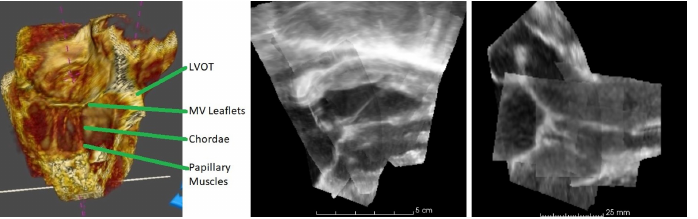
Figure 8. Visualizations of compounded TEE data from five different TEE volumes. ( Left ), a volume rendered view. ( Middle ), a commissure-commissure slice. ( Right ), an AP